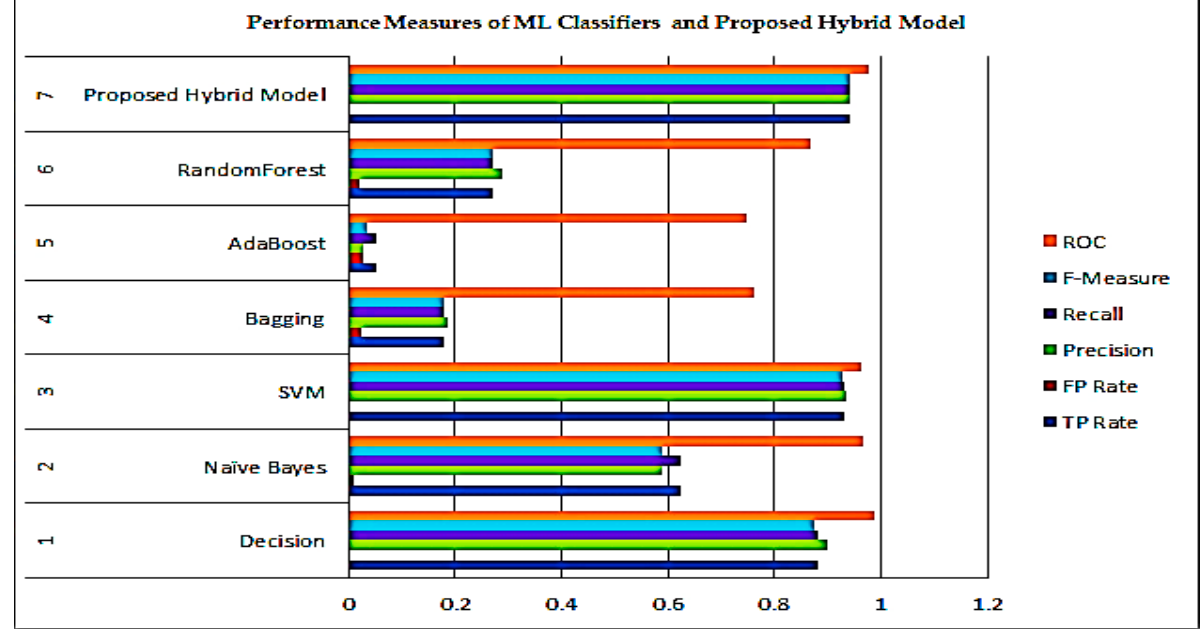
Figure 10. Performance measures of the ML Classifiers and Proposed Hybrid model.